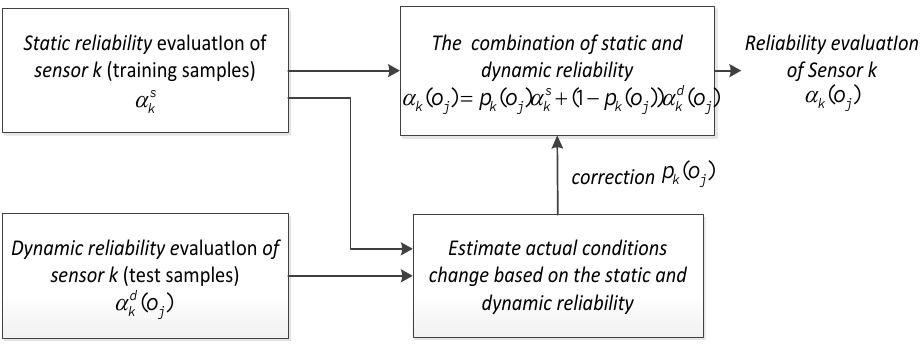
Figure 3. Implementation framework of the our combining